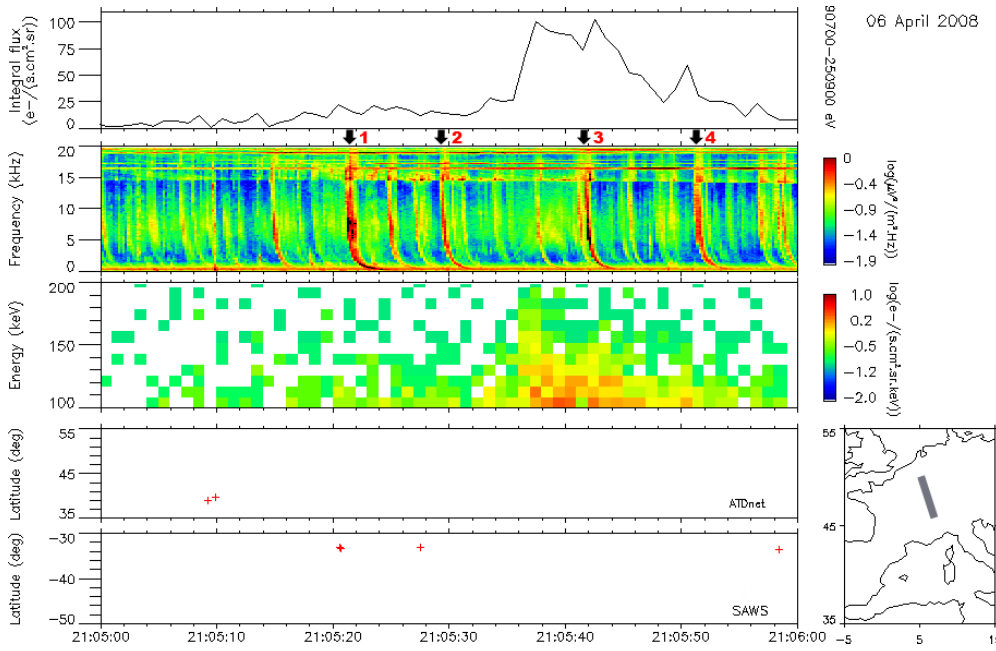
Figure 7. LEP over Europe associated with an active storm in the geographical conjugate area on 6 April 2008. From top to bottom: integral electron energy flux from 90 to 250keV; wave-frequency–time spectrogram between 0 and 20kHz (the arrows indicate four intense whistlers); energy–time electron spectrogram from 100 to 200keV; lightning occurrences from ATDnet; lightning occurrences from SAWS. The map shows the trajectory of the spacecraft (grey) when LEP are detected.